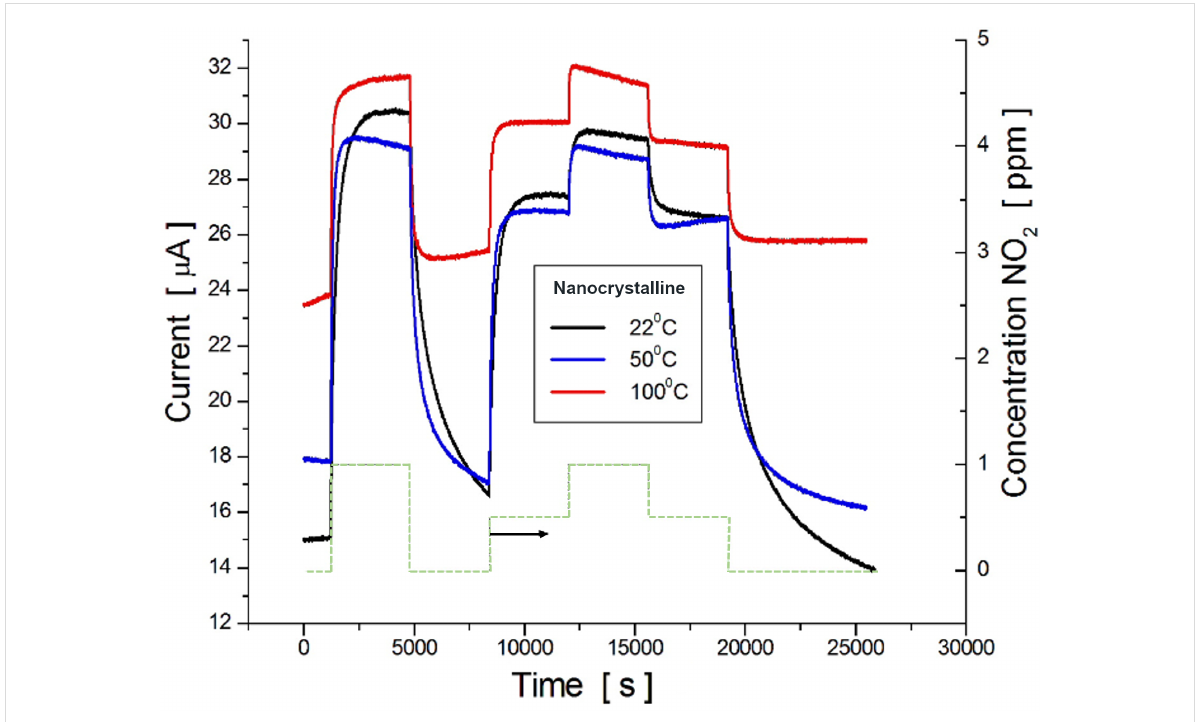
Figure 4: Transient characteristics of gas-induced current in nanocrystalline Te films, at different temperatures, due to the exposure to various NO 2 concentrations, according to the profile shown by the green dashed line at the bottom.